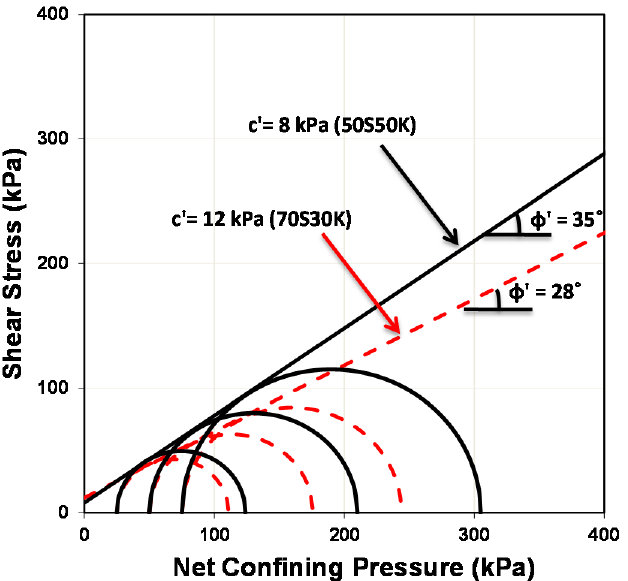
Figure 10. Mohr circle of soil specimens 70S30K and 50S50K at matric suction of 0 kPa from saturated shear strength test.